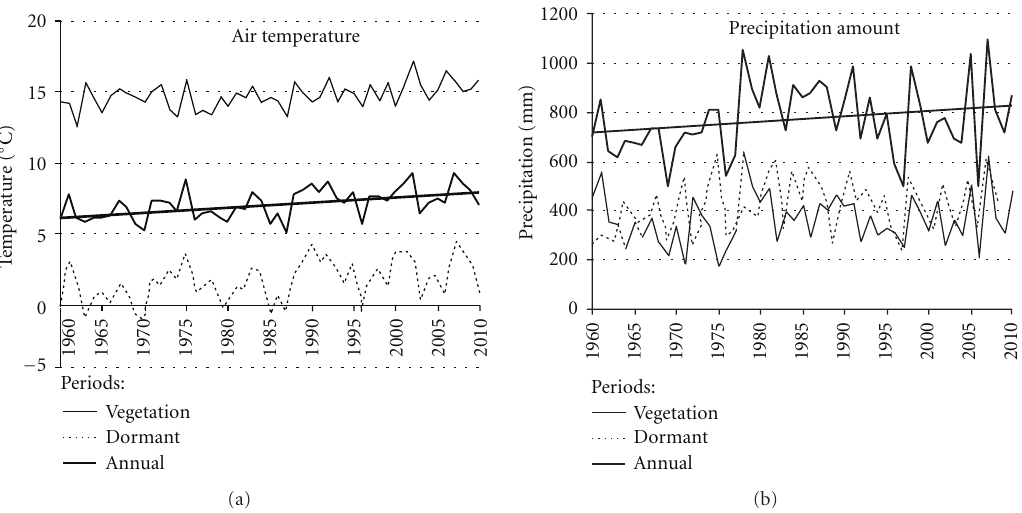
Figure 3: Changes in main meteorological parameters over the last 50-year